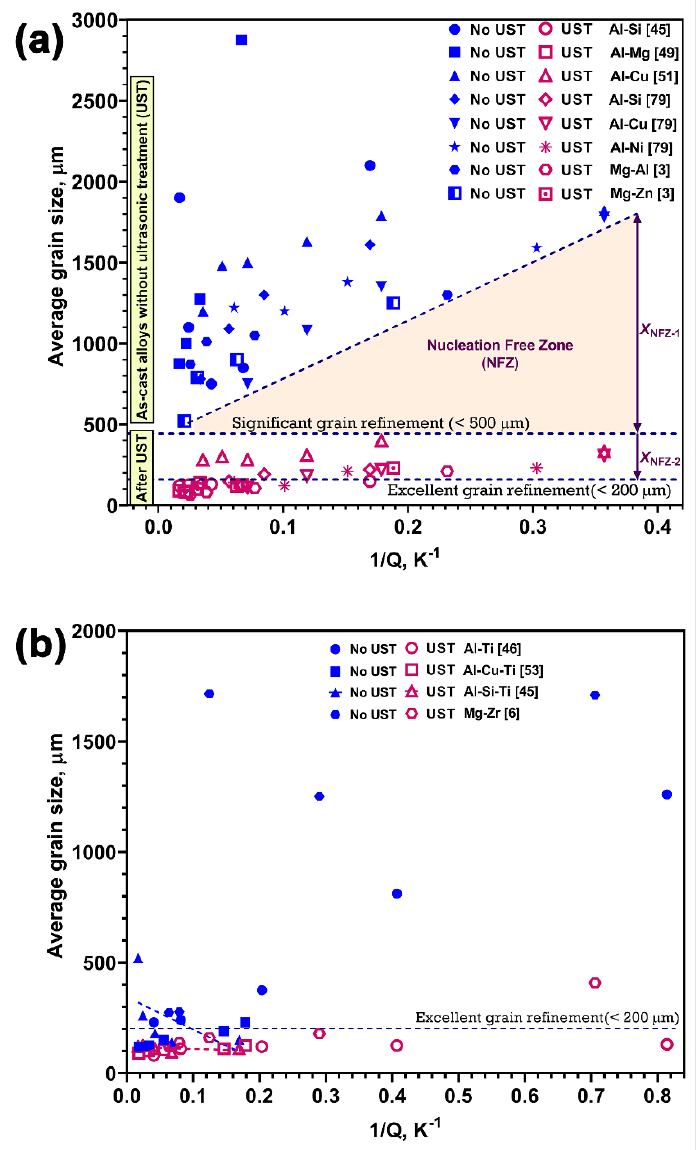
Figure 18. Grain size vs. 1/Q graphs for ( a ) eutectic and ( b ) peritectic alloys solidified under UST.